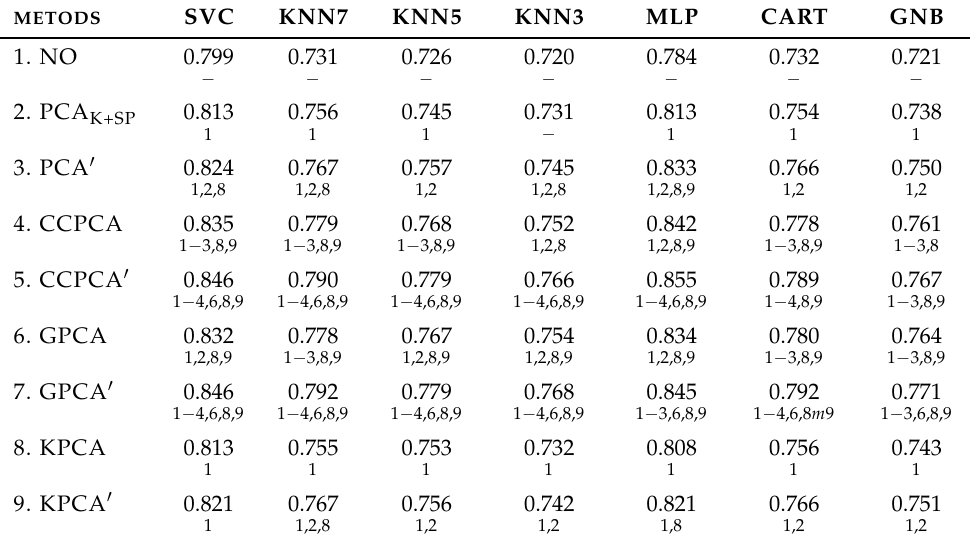
Table 2. Results of experiment 3 for the case of using the proposed method of determining the number of components and features in various extraction methods with the BAC- score metric. The lines contain extraction methods and the columns contain